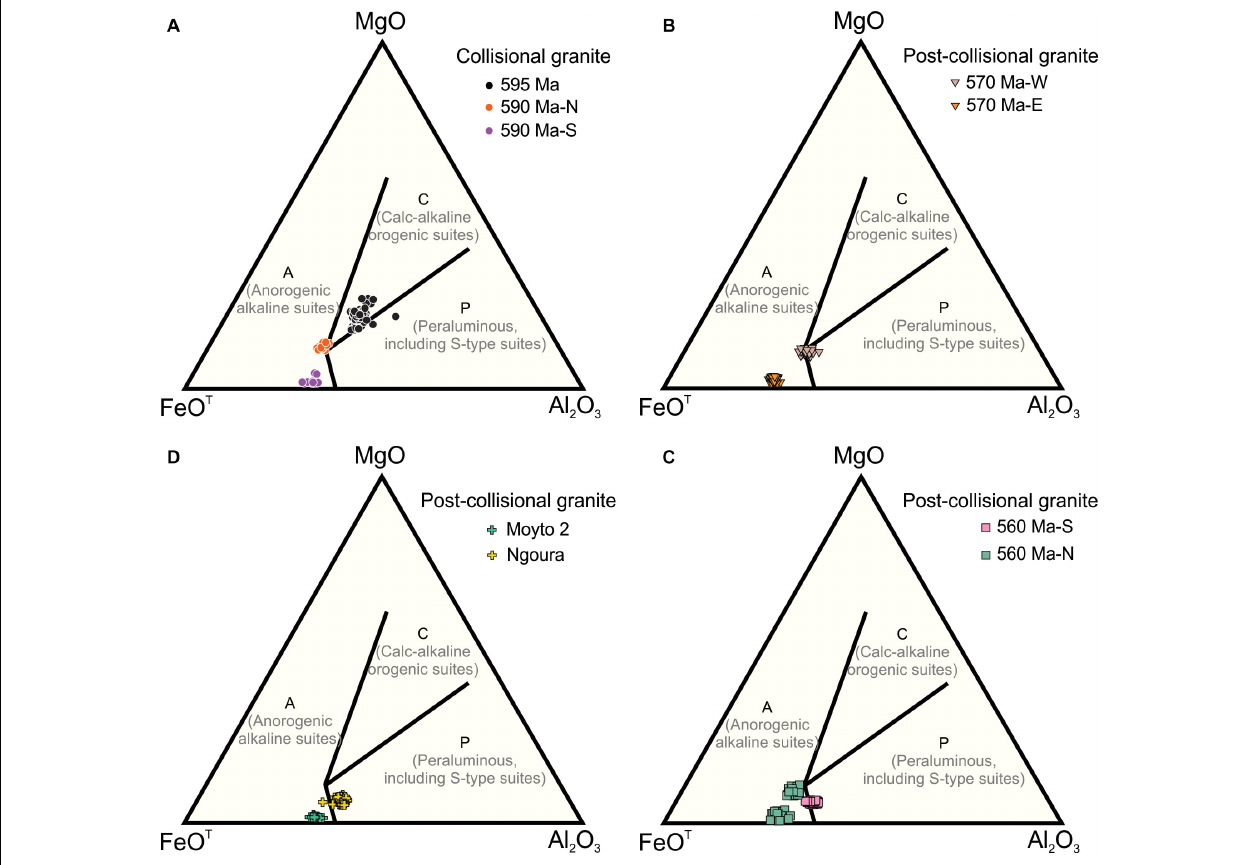
FIGURE 9 | Classification of biotite using the FeO-MgO-Al 2 O 3 tectonomagmatic discrimination diagram of Abdel-Rahman (1994). (A) Collisional granites, (B) 570 Ma post-collisional granites, (C) 560 Ma post-collisional granites, and (D) post-collisional granites from Lake Fitri. Lake Fitri data from Shellnutt et al. (2018).